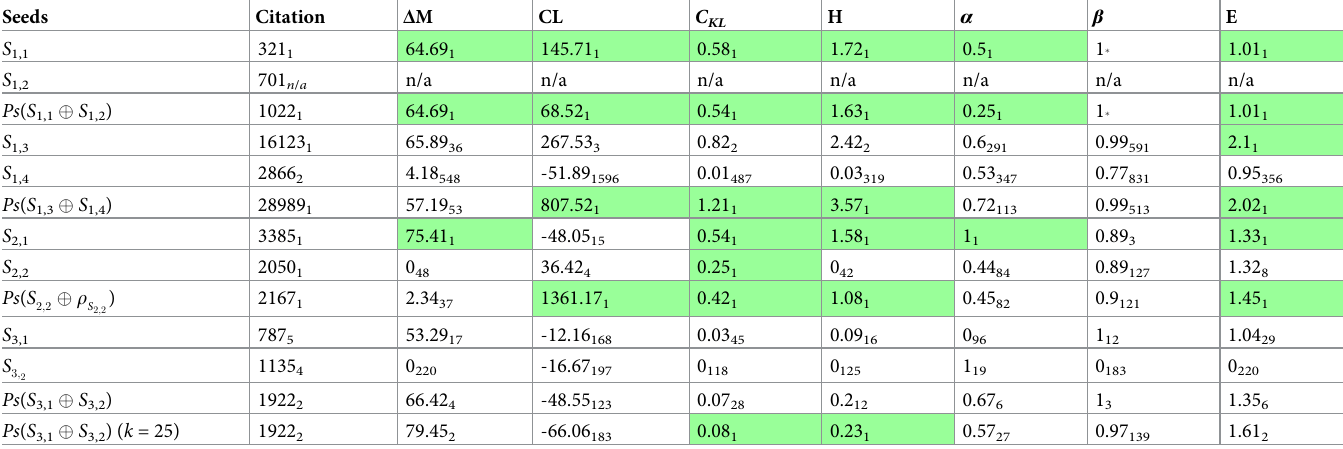
Table 8. Summary performance of SVA metrics for Cases 1–3. The pseudopaper strategy amplifies SVA signals that are otherwise hard to detect from the original seed papers. Ps (